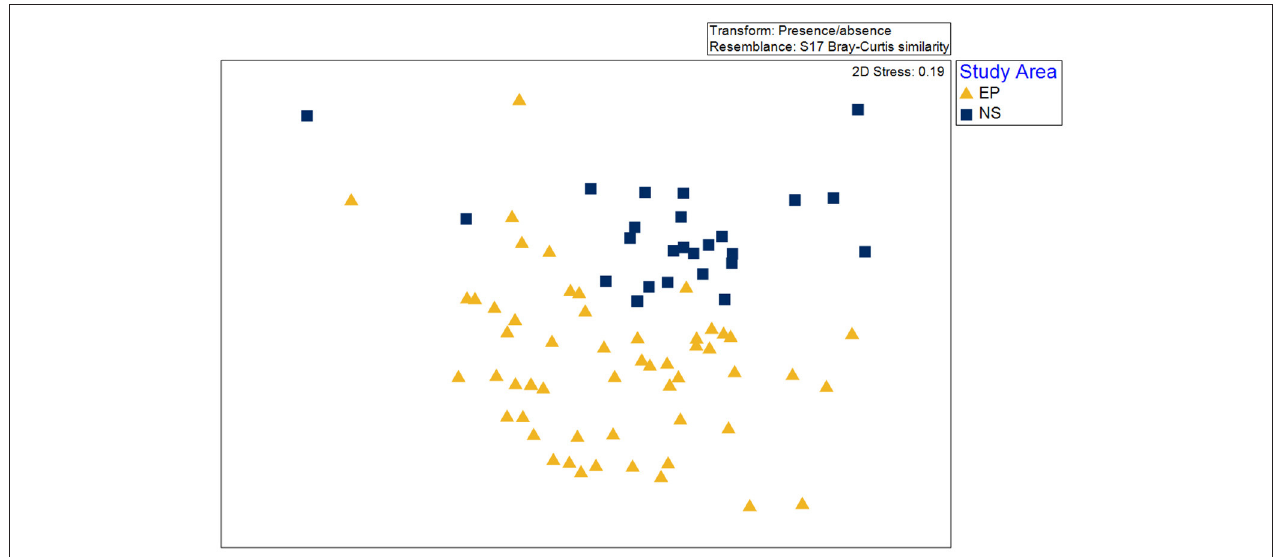
FIGURE 10 | Non-metric multidimensional scaling (nMDS) as a visualization of difference between species composition within video transects collected in the Eastport MPA (EP) and the surrounding Newman Sound (NS)